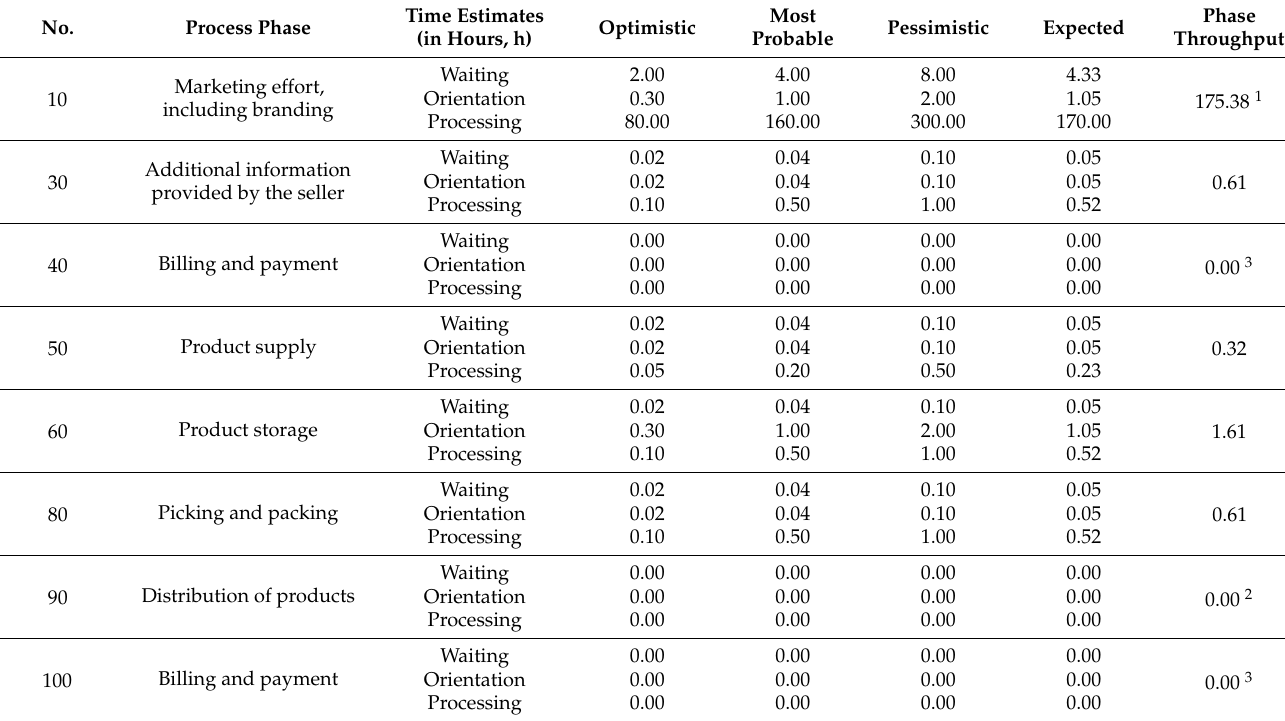
Table 8. Time estimates of the online sales channel’s phases.